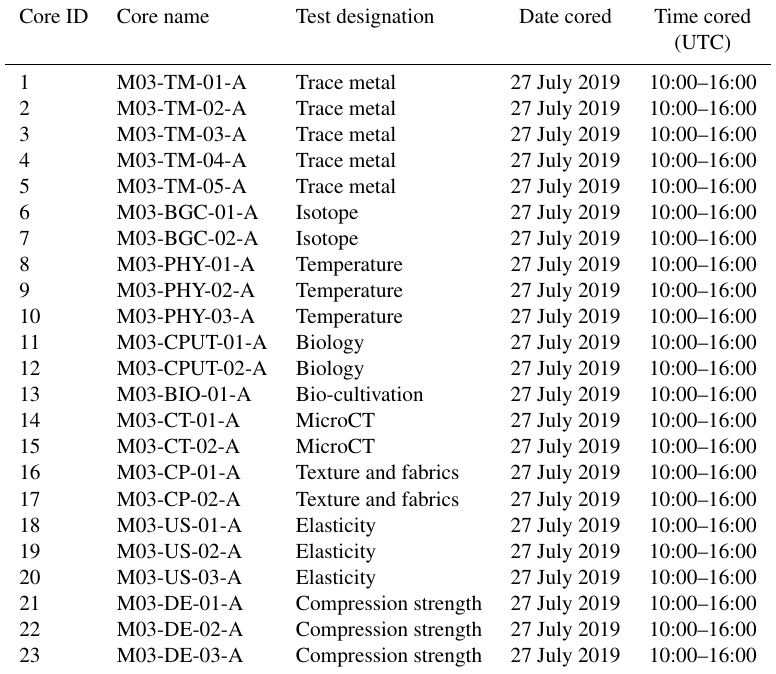
Table A1. Overview of pack ice core IDs, corresponding core names, testing designation, and date and time when